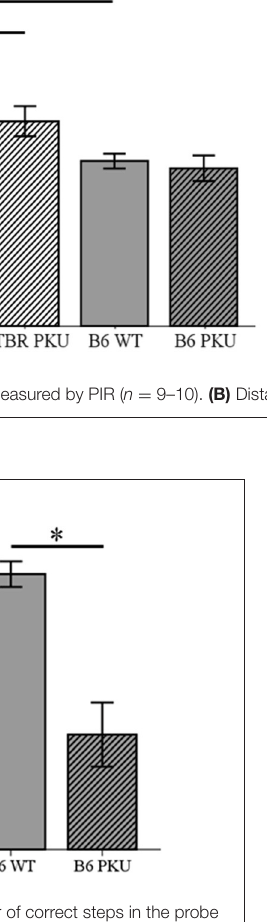
FIGURE 5 | Motor performance. The number of correct steps in the probe trail is depicted as a percentage of the total steps necessary to cross the beam ( n = 9–10). * p ≤ 0.05; mean ±